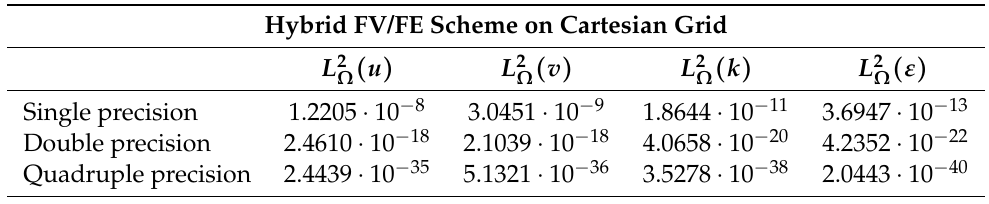
Table 4. Spatial L 2 − error norms obtained for the turbulent Couette flow at time t = 10 using the hybrid FV/FE method for Cartesian grids and for unstructured simplex